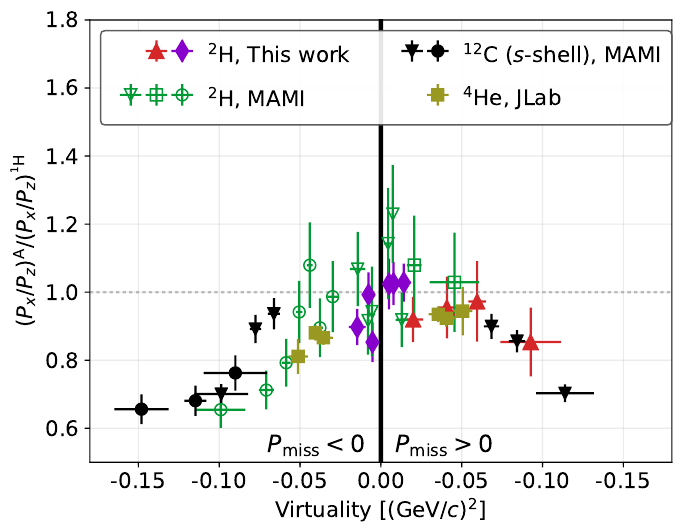
Figure 7: The double ratio (3) for ( 2 H, 4 He and 12 C) as a function of virtuality. As virtuality is always negative, the two branches of the plot are defined by the sign of missing momentum (its direction relative to momentum